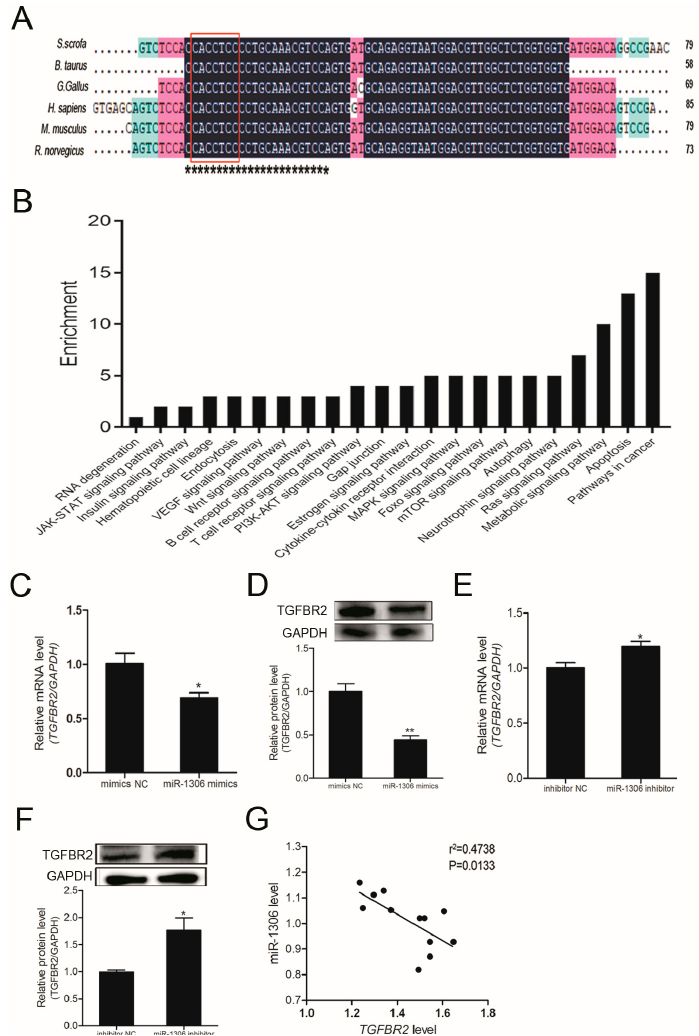
Figure 1. MicroRNA-1306 (miR-1306) inhibits endogenous transforming growth factor- β receptor II (TGFBR2) expression in porcine granulosa cells (GCs). ( A ) Multiple-sequence alignment of pre-miR-1306 from six different species. miR-1306 mature sequences are indicated by black asterisks. Seed sequences of miR-1306 are indicated in red boxes. S. scrofa, Sus scrofa; B. Taurus, Bos taurus; G gorilla, Gorilla gorilla; H.sapiens, Homo sapiens; M.musculus, Mus musculus; R norvegicus, Rattus norvegicus. ( B ) Kyoto Encyclopedia of Genes and Genomes (KEGG) analysis showing the pathways targeted by miR-1306. ( C , E ) Results of Quantitative RT-PCR (qRT-PCR) showing TGFBR2 mRNA levels and ( D , F ) Western blotting results showing the TGFBR2 protein levels after miR-1306 mimics or inhibitor were transfected into porcine GCs, respectively ( G ) Correlation analysis between miR-1306 and TGFBR2 ( n = 12). The data is represented by mean ± SEM. * indicates p <0.05; ** indicates p <0.01.